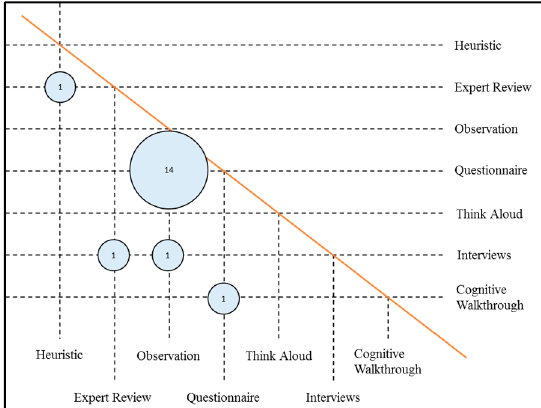
Figure 11. A number of two technique combinations.